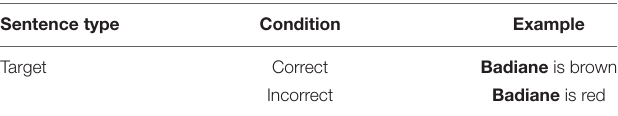
TABLE 1 | Examples of the correct and pragmatically incorrect